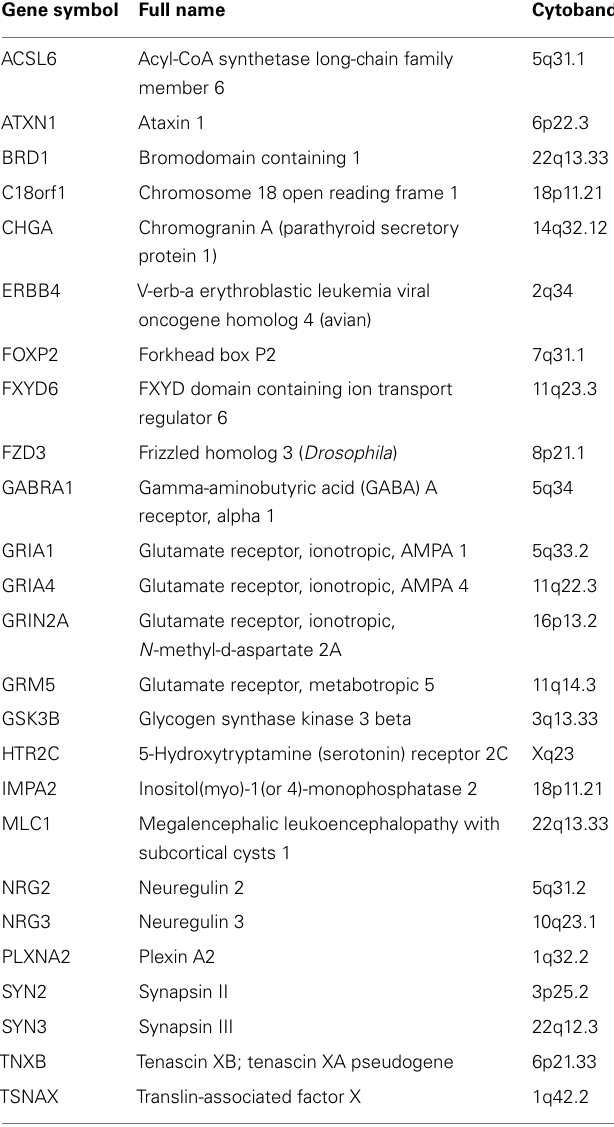
Table 1 | SZGR associated miR-137 target